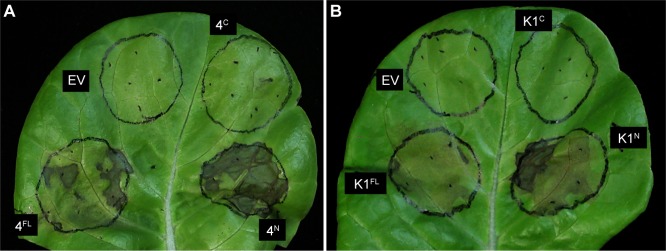
AvrRps4N and HopK1N are sufficient to trigger a hypersensitive response in lettuce.(A) Agrobacterium C58C1 containing the constructs for transient expression of N-terminally HA-tagged AvrRps4 full-length (4FL), AvrRps4N (4N), AvrRps4C (4C), and HA-pBA empty vector (EV) was infiltrated into Lactuca sativa cv. Kordaat at an O.D. of 0.3. (B) Equivalent experiment with HopK1 full-length (K1FL), HopK1N (K1N), HopK1C (K1C), and HA-pBA empty vector (EV). Cell death phenotypes in (A) and (B) were visualized three days post-infiltration. These experiments were repeated four times with identical results.